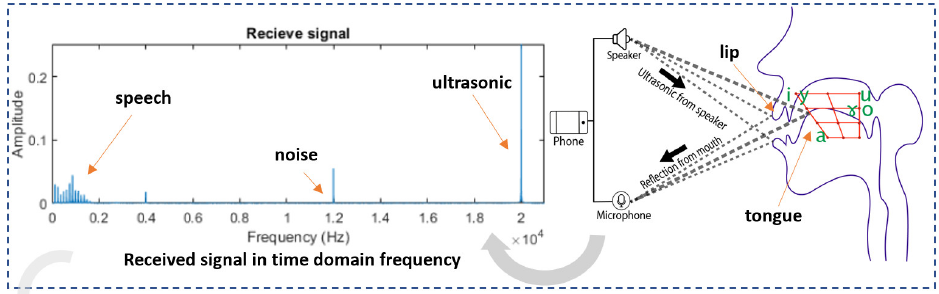
Figure 1. The sample signal in the frequency domain shows two ranges of acoustic signals: the speech signal and ultrasonic signal of the Doppler effect from the articulation movement.